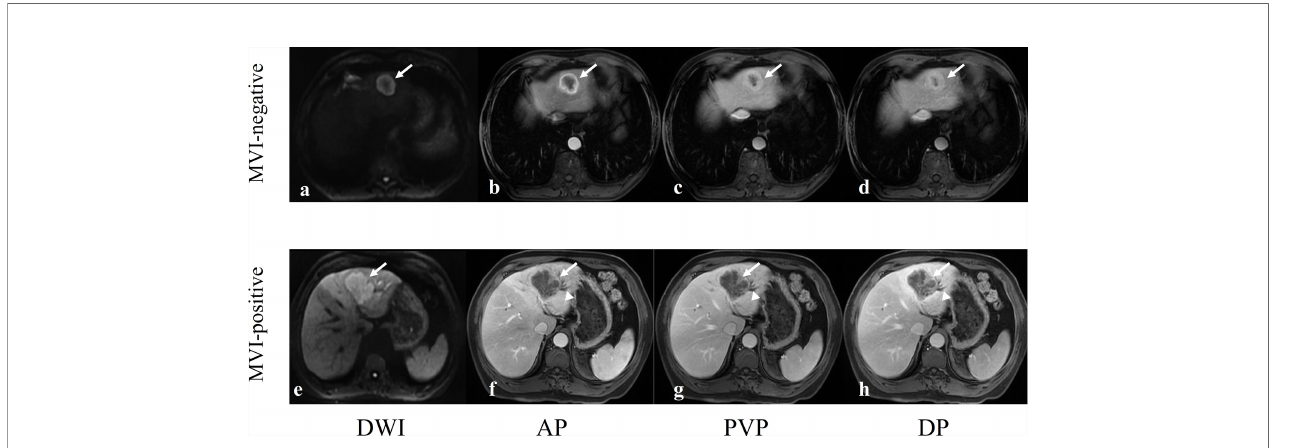
FIGURE 3 | Two examples of representative MVI-negative and MVI-positive ICCs. (A – D) A 62-year-old man with a well-circumscribed MVI-negative ICC in hepatic segment II (arrows). DWI image showed target sign (A) , axial arterial phase image showed rim enhancement (B) , and portal vein phase image (C) and delayed phase image (D) showed the typical enhancement type of ICC: gradual and fi lling enhancement. (E – H) A 62-year-old man with a lobulated MVI-positive ICC in hepatic segment IV (arrows). DWI image showed hyperintensity (E) , axial arterial phase image showed marginal moderate enhancement with no internal enhancement (F) and dilated bile ducts next to tumor (arrowheads), and portal vein phase image (G) and delayed phase image (H) showed the typical enhancement type of ICC: gradual and fi lling enhancement.